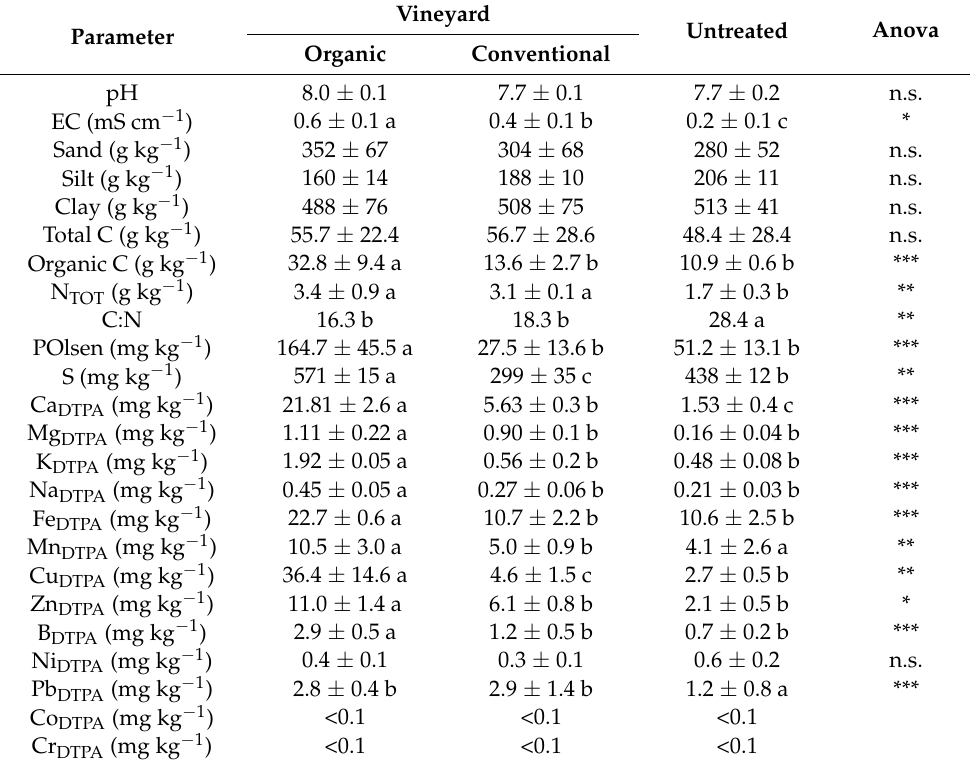
Table 2. Physical and chemical characteristics of the soil top layer of the vineyards amended with the wood-based compost (OV), conventionally fertilized (CV), and untreated soil. Values represent the average of 10 replicates (main ± standard